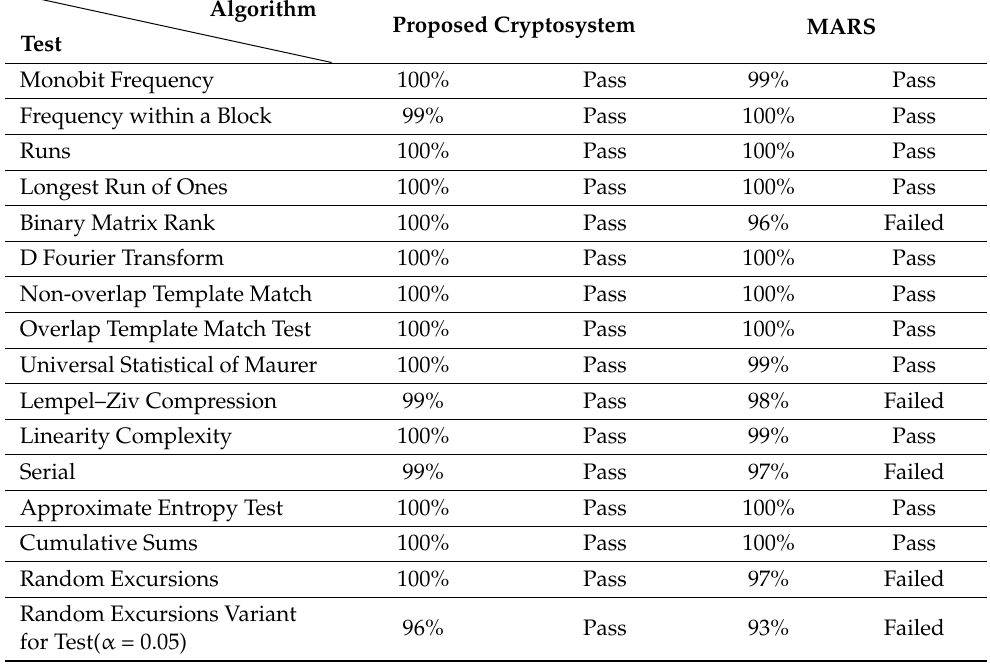
Table 4. The average values of the statistical tests for the proposed system and MARS